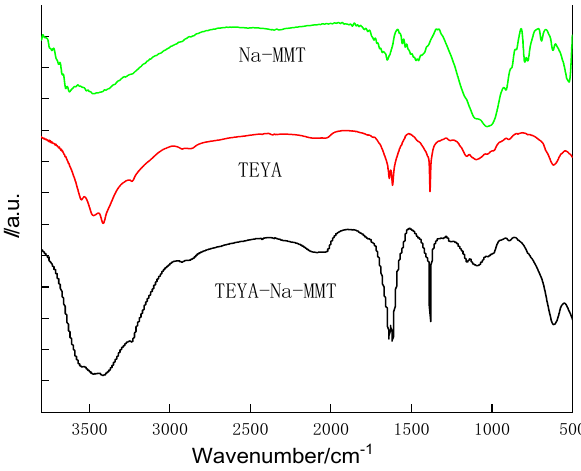
Figure 5. FT-IR spectra of Na-MMT, TEYA and Na-MMT/TEYA. For the curve of Na-MMT, 3451 cm − 1 , 1020 cm − 1 and 1645 cm − 1 correspond to the absorption peaks of -OH stretching vibration, Si-O stretching vibration and variable angle vibration of interlayer water molecules in bentonite, respectively [35]. The infrared spectra of TEYA/Na-MMT contained all the characteristic absorption peaks of the TEYA and Na-MMT, and no new peak appeared, which indicated that TEYA and Na-MMT were effectively combined together. However, the position of the absorption peak of Na-MMT was